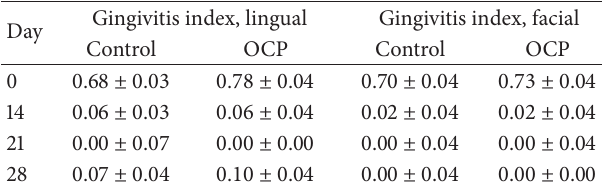
Table 5: Gingivitis index for facial and lingual surfaces of all teeth assessed (collapsed by tooth) of control and treatment (OCP) dogs. Note that the gingivitis index on day 0 represents effects of cleaning on the gingiva. No cleaning was performed prior to gingivalassessmentsondays14,21,and28.Therewerenodifferences between treatments or between days 14, 21, and